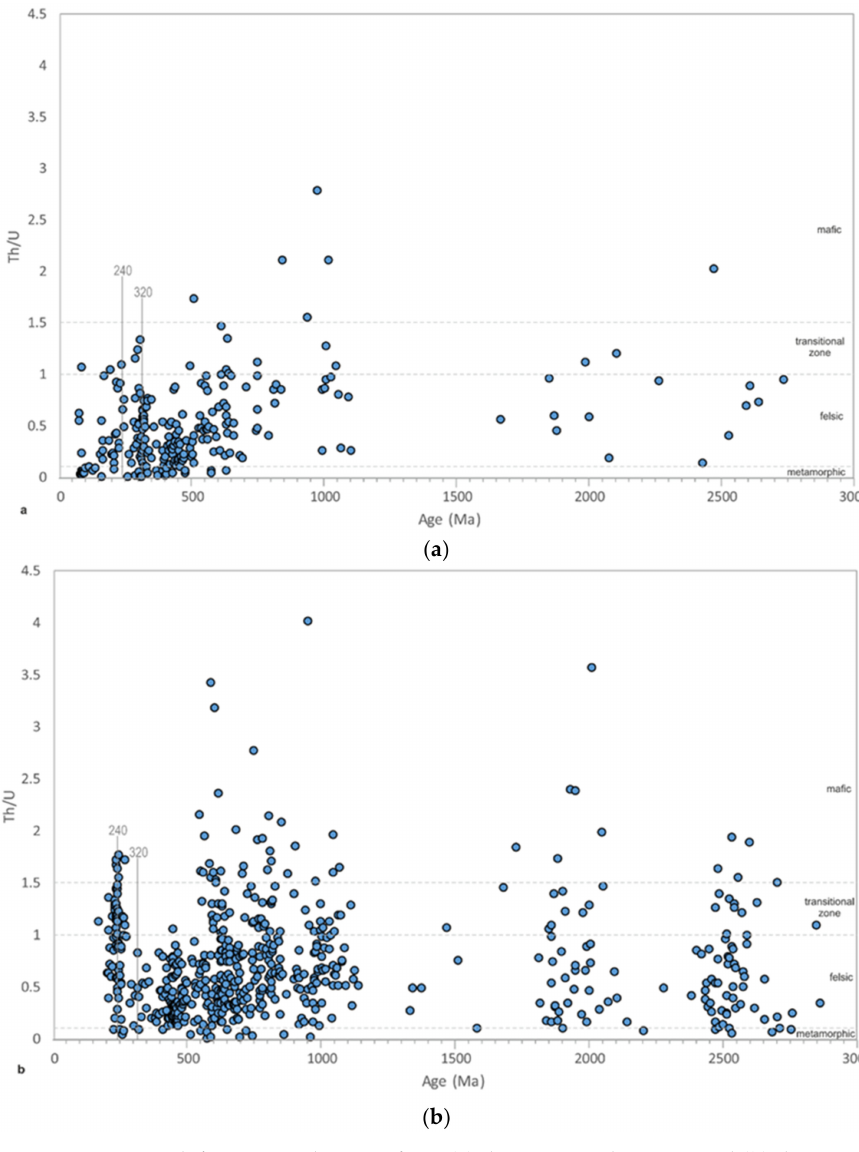
Figure 9. Zircon Th/U vs. age diagram from ( a ) the Upper Schist Fm. and ( b ) the Lower Schist Fm. of Iraklia